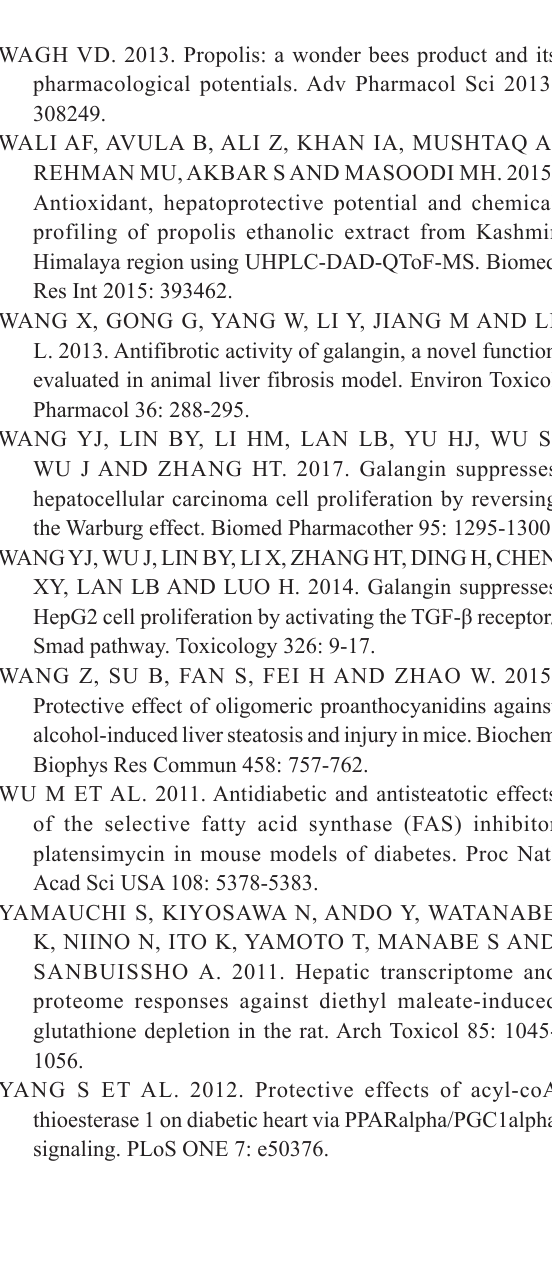
Table SI - Retention times (RTs) and percentages of relative area (%) of chemical constituents in EEP detected by GC-MS. Table SII - The body weight, organ weight, relative organ weight, and serum biochemical indexes of rats in different groups. Figure S1 - Body weights of rats in different experimental groups. Figure S2 - Histological features of represrntative liver